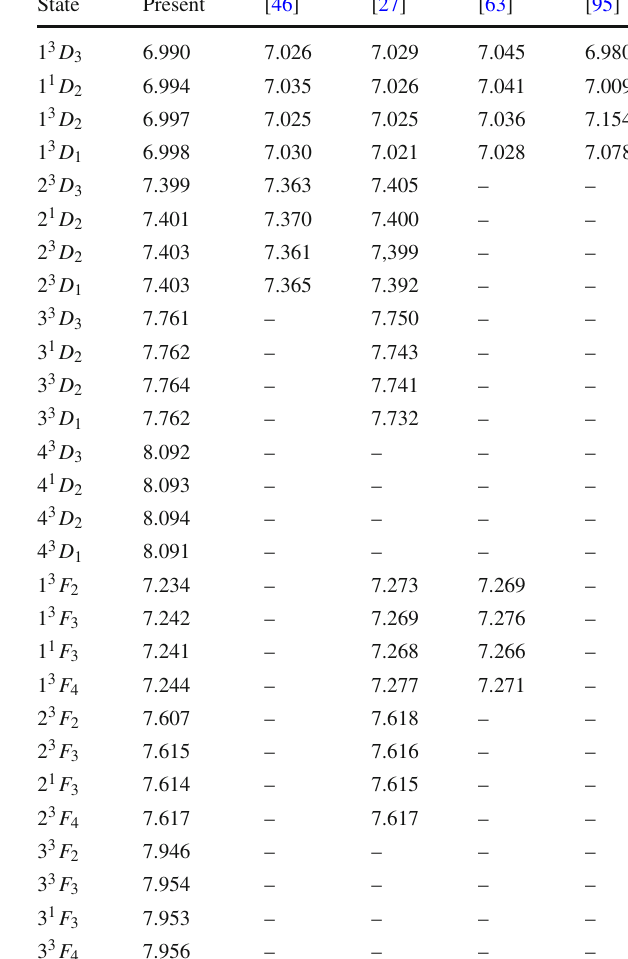
Table 7 Mass spectrum of D and F -wave B c meson (in GeV)